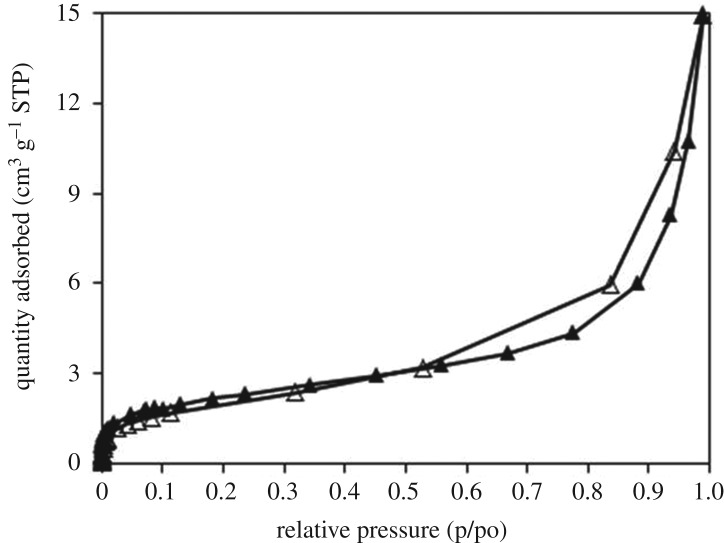
Nitrogen adsorption/desorption isotherm of the La0.6Sr0.4CoO3 perovskite. Adsorption data are shown as closed triangles and desorption data as open triangles.